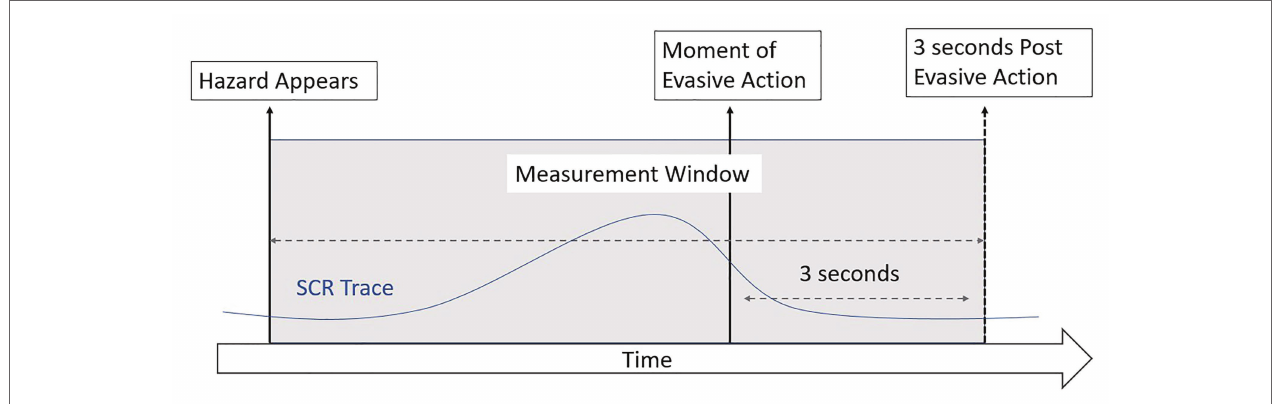
FIGURE 1 | Measurement windows for event